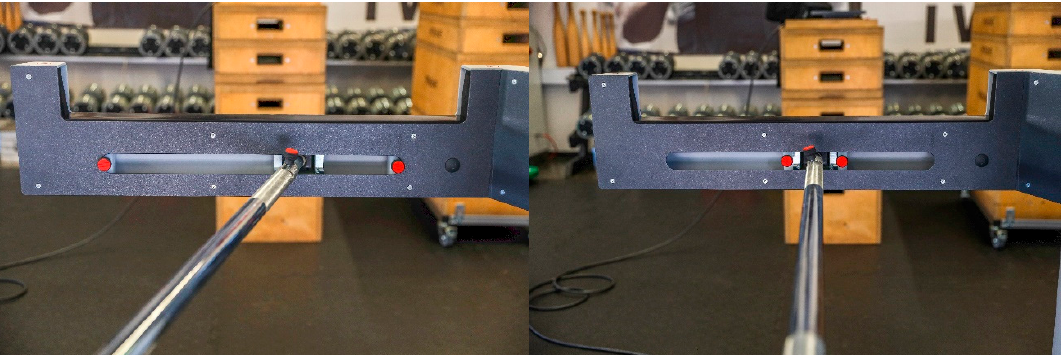
Figure 5. The simulation bar free (left) and locked (right).